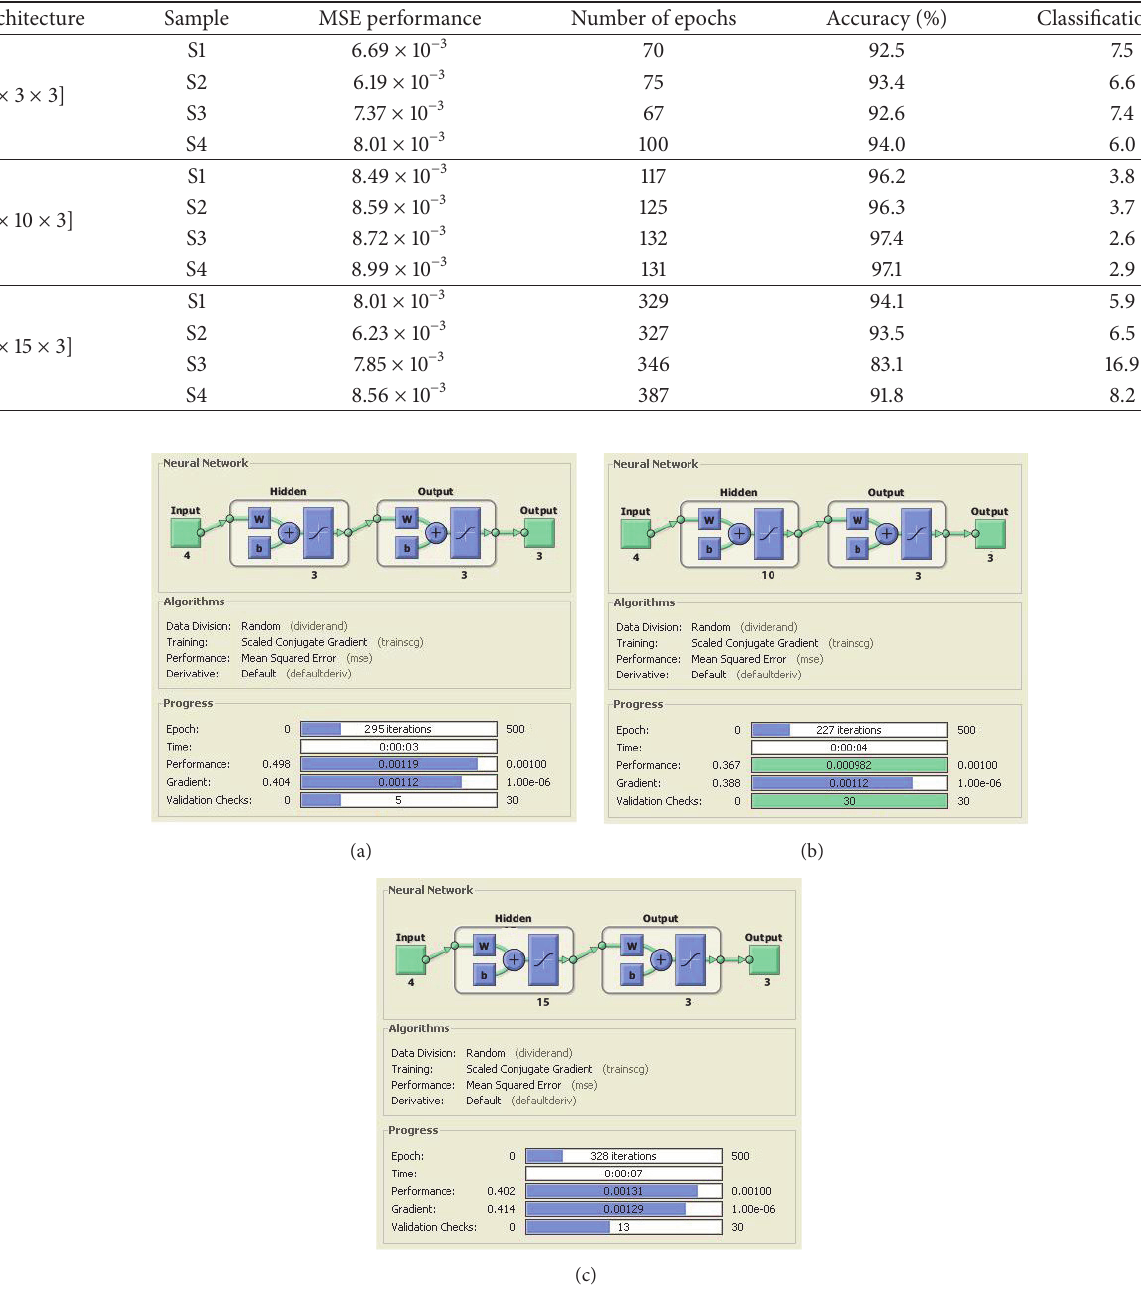
Each diagonal cell indicates the number of cases that have been classified correctly by the neural network, to identify feature condition, whether healthy or faulty for each motor. The cells in red colour point out the number of cases that have been erroneously classified by the ANN model or where the state of sample features were not clearly acknowledged. The blue cell indicates the overall percentage of tested cases that were classified correctly in green and the vice-versa in